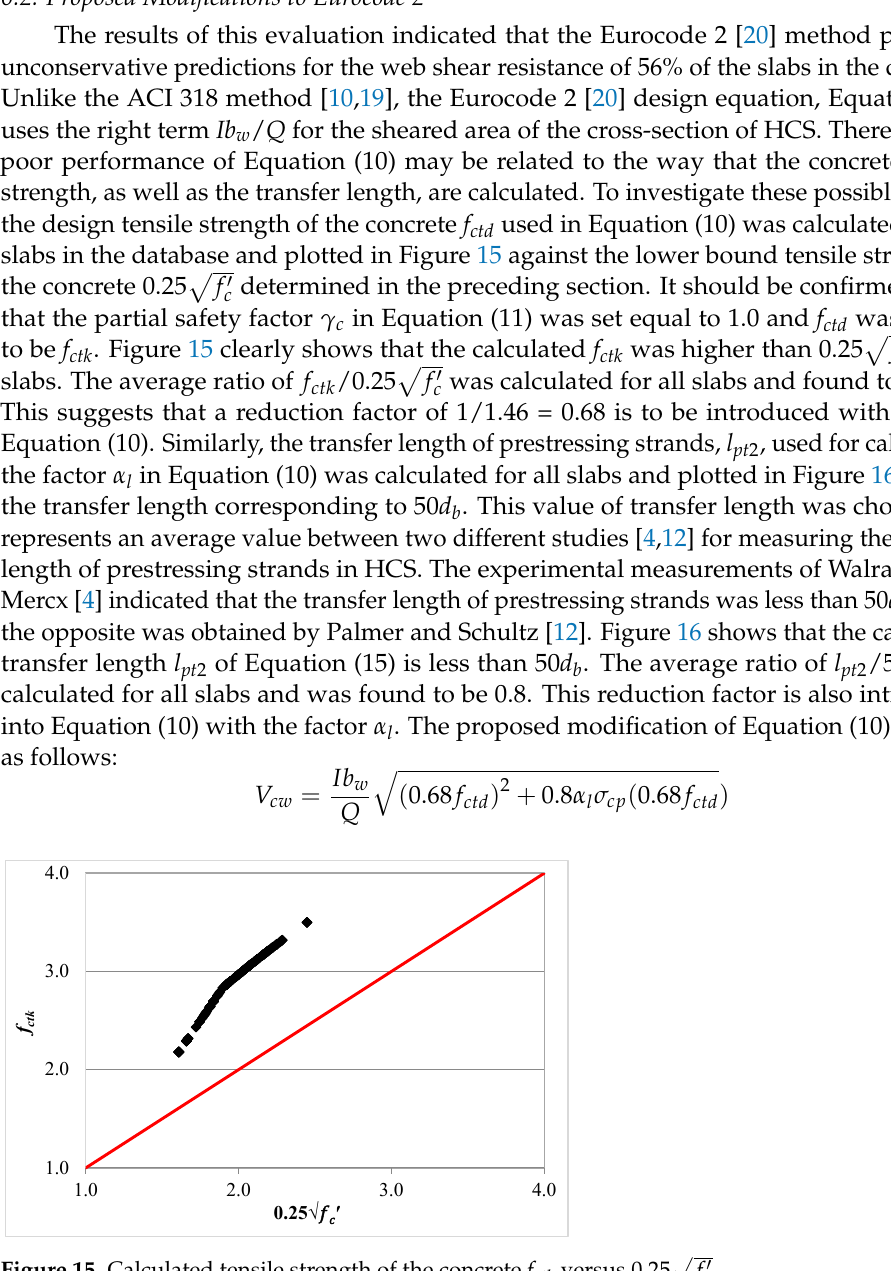
ctk versus 0.25(cid:3493)𝑓 (cid:3030)(cid:4593)